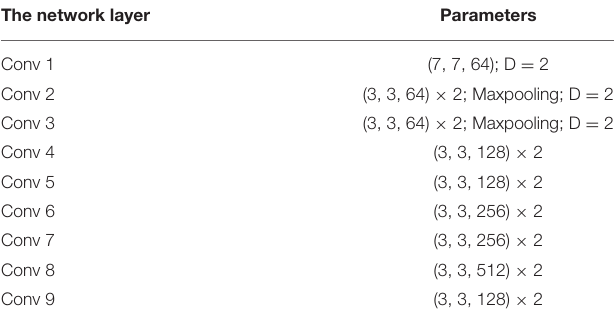
TABLE 1 | Network